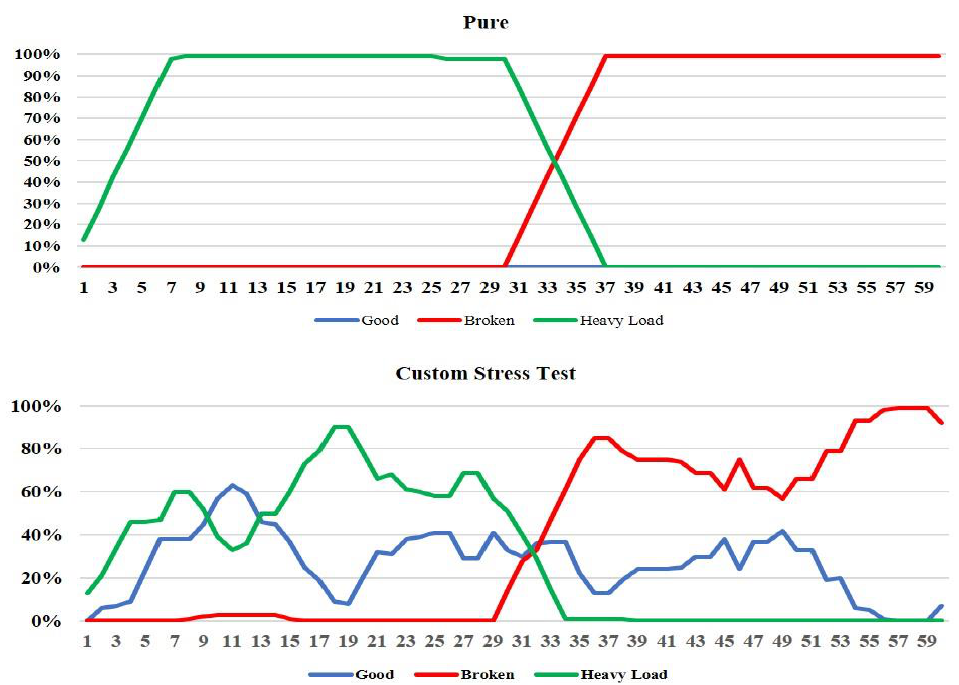
Figure 5. Performance of CNN model of the STM’s methodology for the heavy load to broken state transition test.